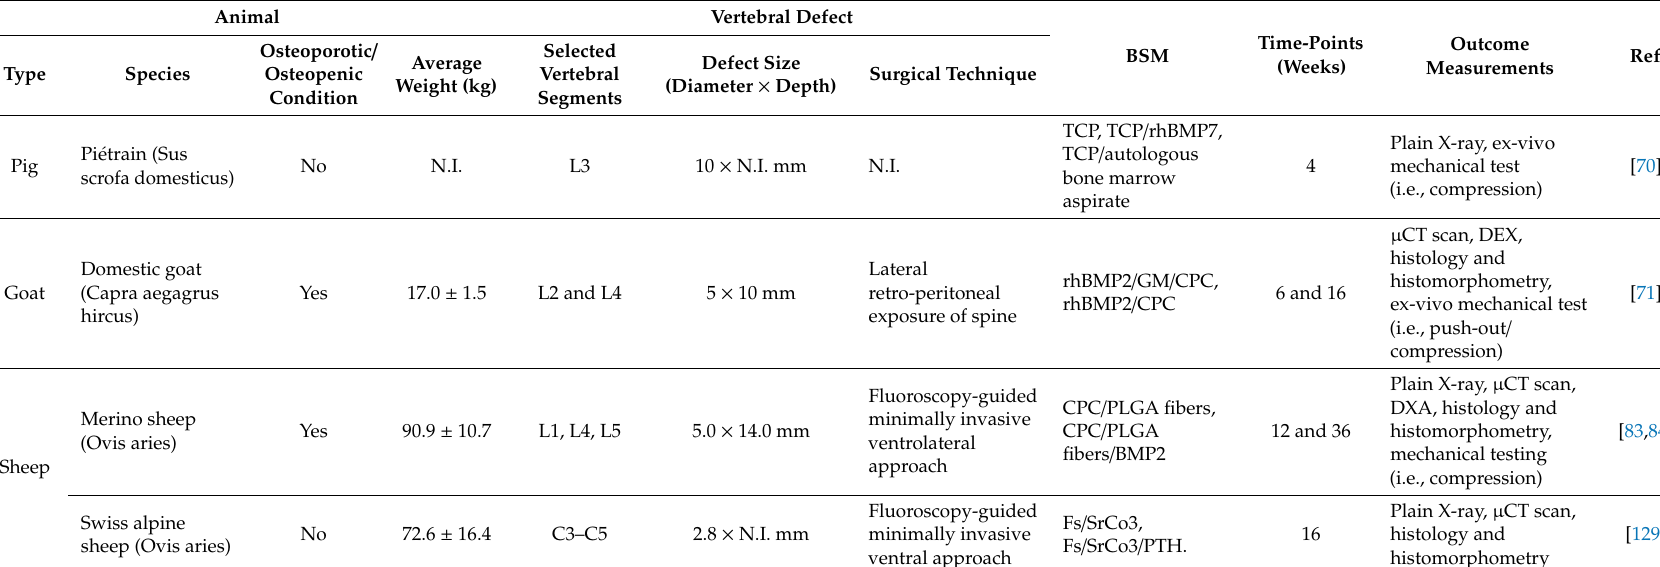
Table 3. Selection of preclinical vertebral augmentation studies for biological BSM